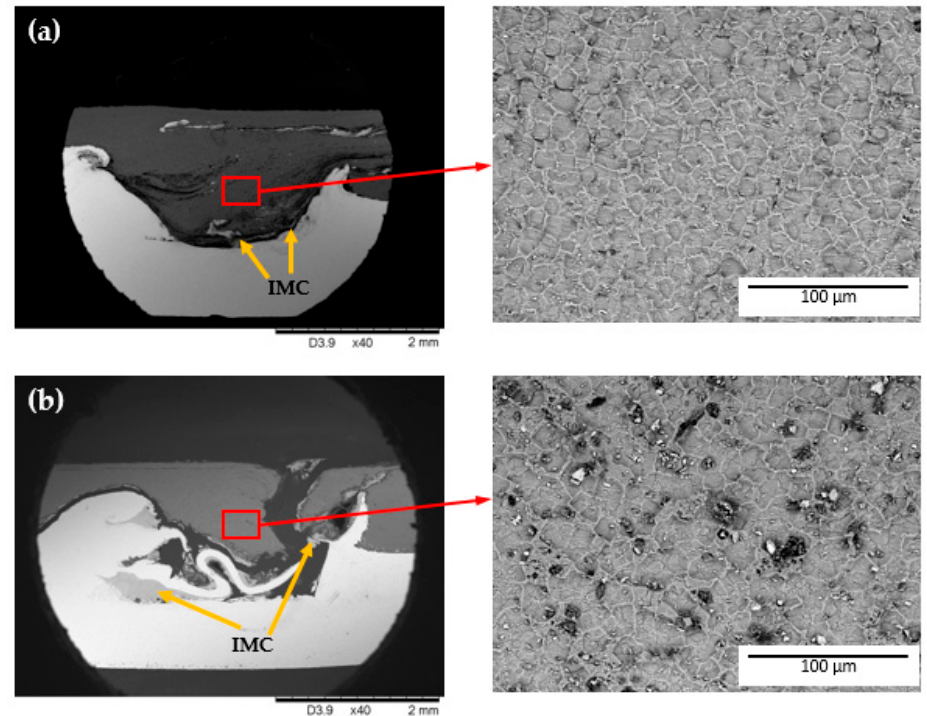
Figure 10. Scanning electron microscope (SEM) image of stirred zone (SZ) for ( a ) sample 7 [0% overlap, first pass] and ( b ) sample 25 [100% overlap, first and second pass].